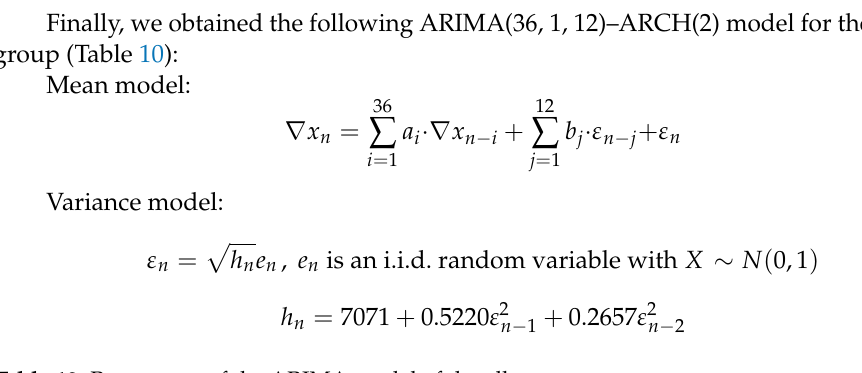
Figure 12. Fitted volatility of the ARCH(2) model’s residual of the Shanghai Index’s daily revenue.